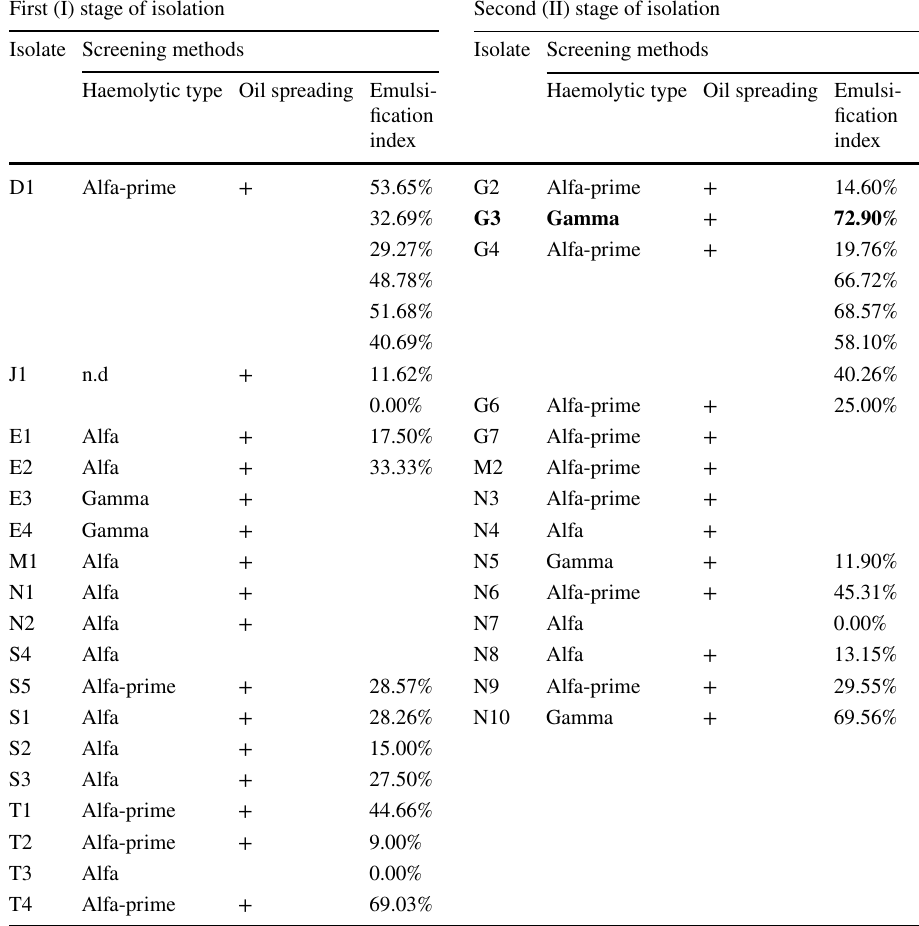
Table 3 Screening result of isolated indigenous bacteria based on hemolytic type, oil spreading, and emulsification